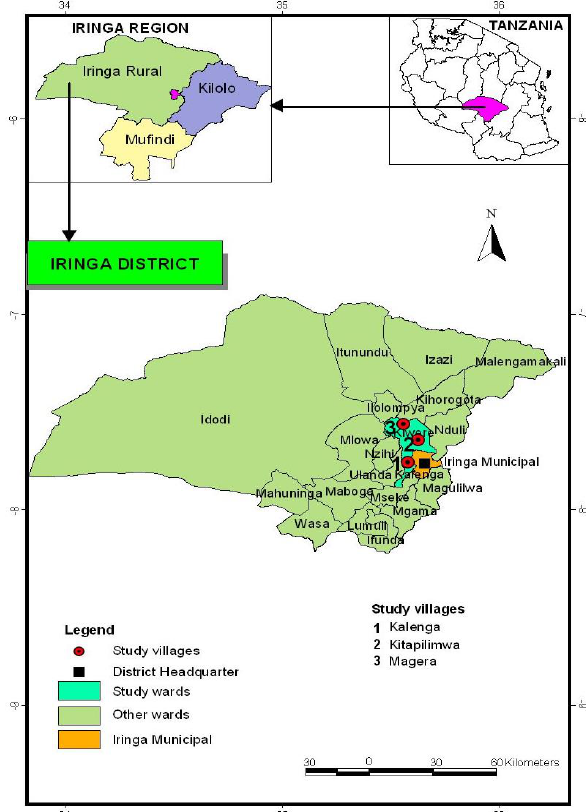
Fig. 1. Map of Iringa District, Tanzania, showing the study